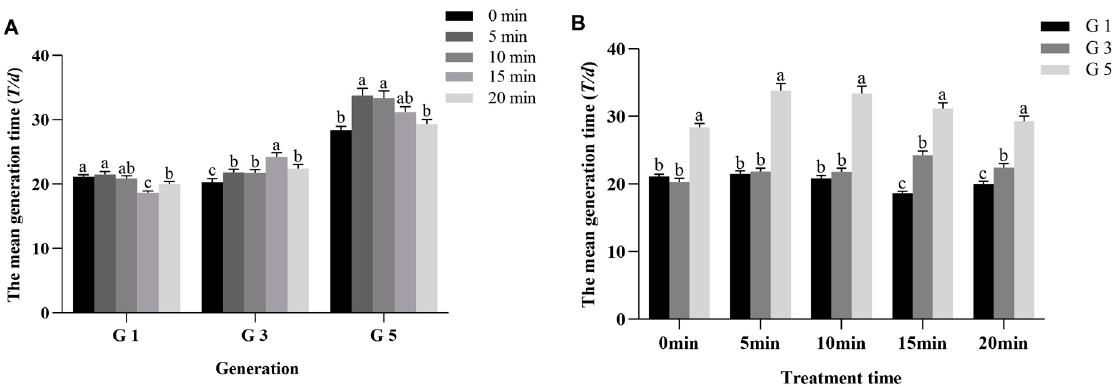
Figure 4. Mean generation time ( T ) of the first, third, and fifth generations of P. xylostella eggs in 5 successive generations after HVEF treatment. Values are expressed as mean ± standard error (SE). ( A ) The different lowercase letters indicates a significant difference at p < 0.05 between generations for groups exposed to electrostatic fields (0, 5, 10, 15, and 20 min). ( B ) The different lowercase letters indicates significant differences at p < 0.05 between treatments for 3 generations (G1, G3, and G5). Differences were compared using the paired bootstrap test.